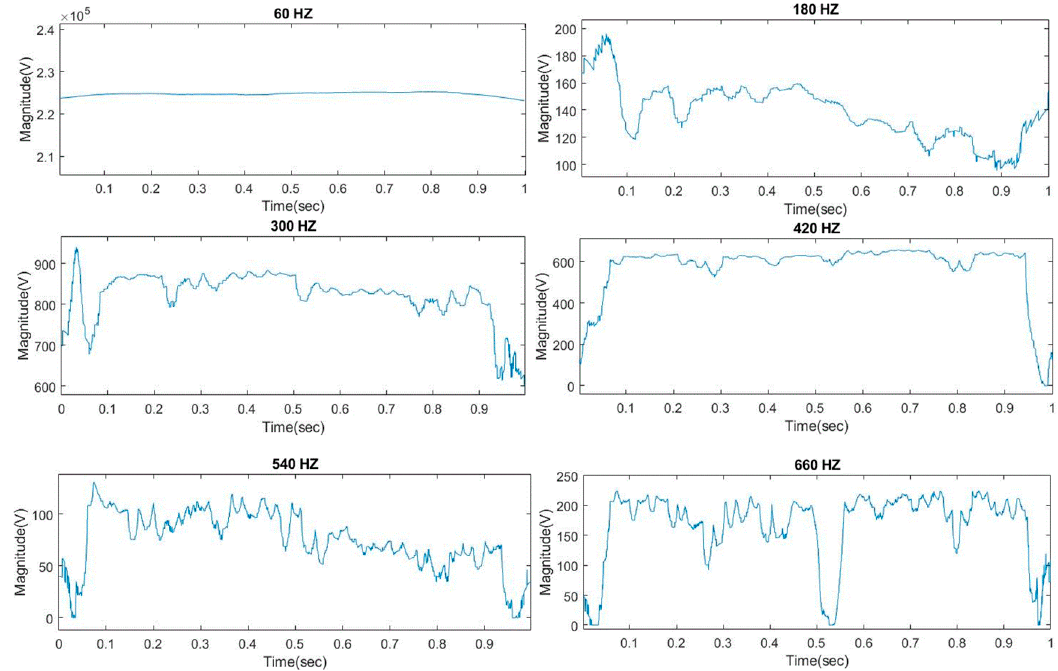
Figure 14. Offshore wind farm case: fundamental and major harmonic voltage magnitude variations of corresponding reconstructed time-domain waveforms in Figure 13.